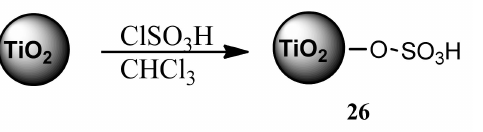
Figure 10. Sulfonic acid-functionalized TiO 2 based on Shirini et al. study